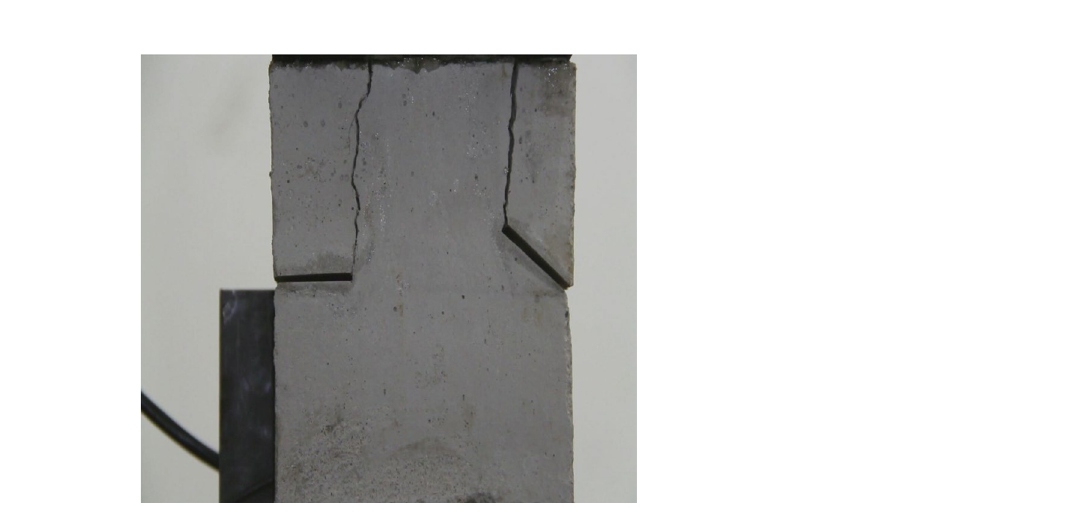
Figure 38. The same specimen shown in Fig. 36 at t = 1807s.